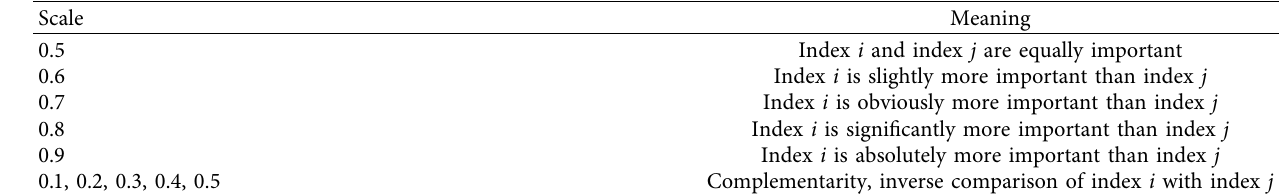
Table 1: The 0.1–0.9 complementary fuzzy scaling